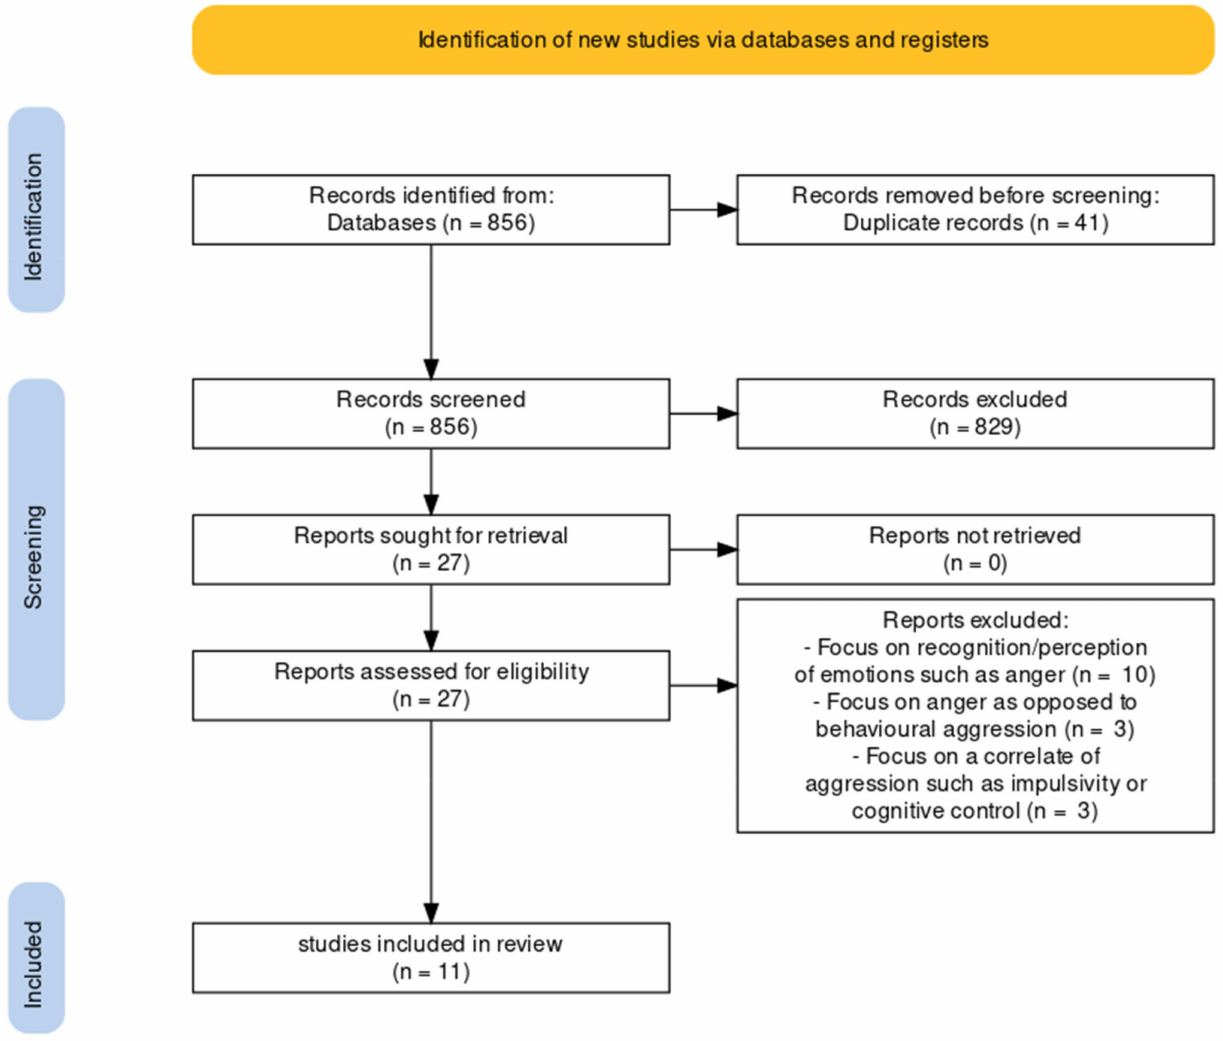
Figure 1. Prisma flowchart showing the selection process of the articles used in the review. Note: The terms ‘report’, ‘article’ and ‘study’ are used